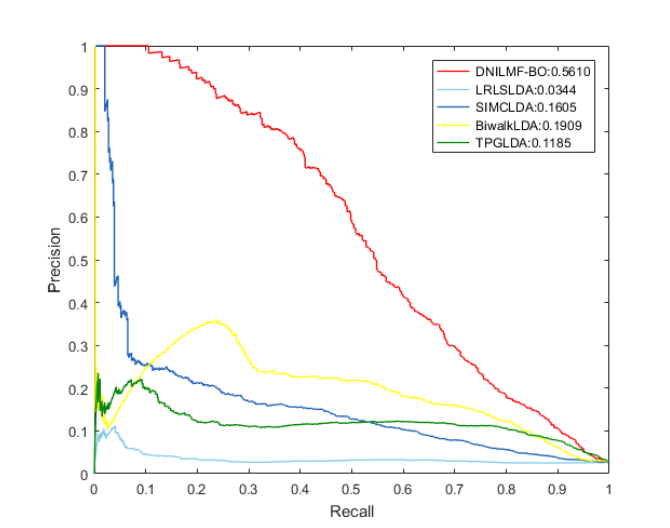
Figure 4. PR curve of the five